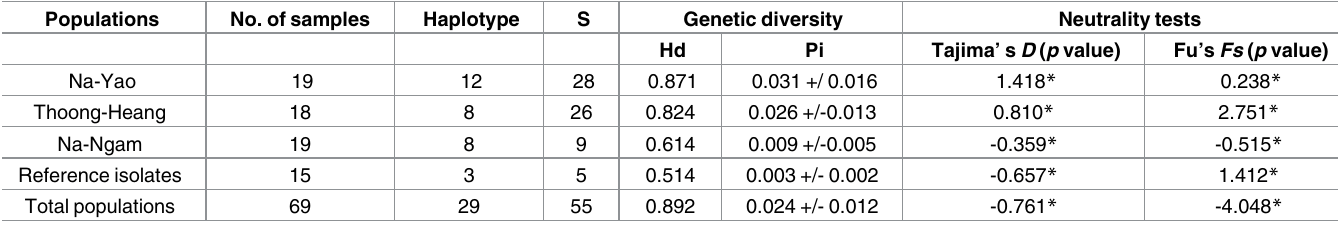
Table 2. The indicators of genetic diversity and neutrality tests in the populations of O . viverrini from three villages using cox1 sequences. Populations